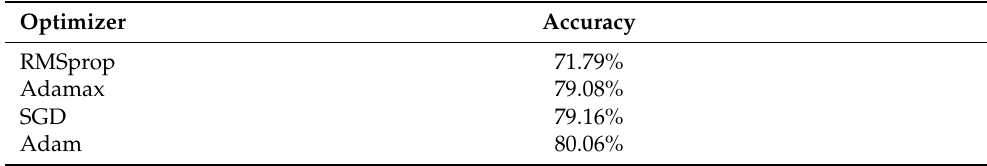
Table 2. Comparison of fish recognition accuracies of various optimization techniques on the LCF-15